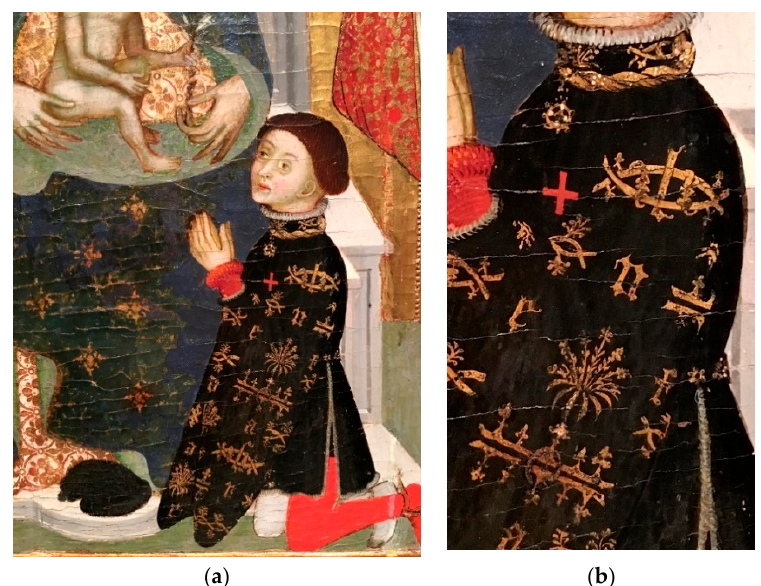
Figure 41. Kneeling donor identified as Martin the Humane as regent of Sicily, Francesc Comes the Younger (?), Triptych with Virgin and Child with St George and St Martin, ca. 1395. © Used with permission of the Isabella Stewart Gardner Museum, Boston. ( a ) Detail of the kneeling donor. ( b ) Detail of the robes of the kneeling donor with the Cross of St George and the double crown.